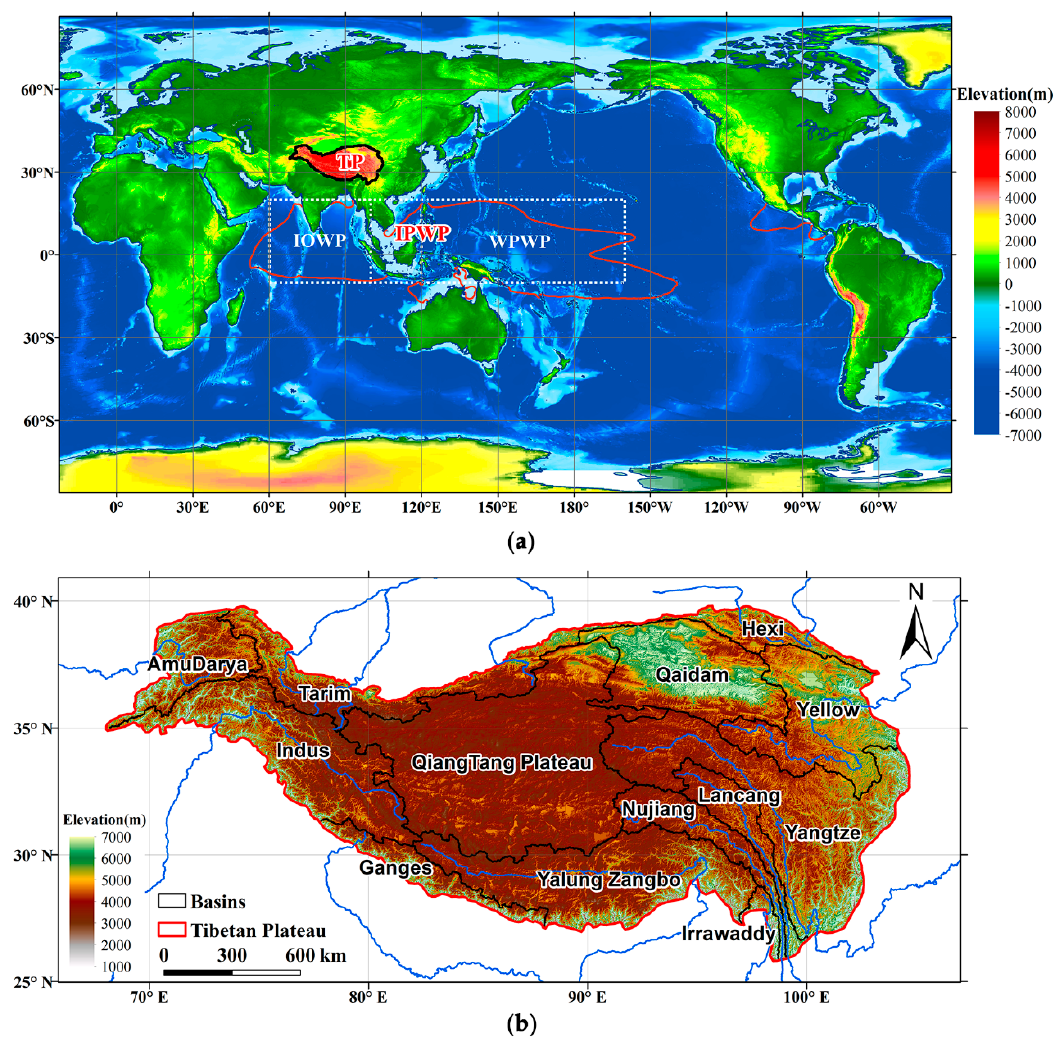
Figure 1. ( a ) The entire study area of the Tibetan Plateau (TP) where the black solid line (elevation greater than 2500 m) is the boundary of the TP, and the Indo-Pacific warm pool (IPWP), where the red line (SST greater than 28 ◦ C) is the annual-averaged boundary of the IPWP. The dotted white lines are the rectangular boundaries of the Indian Ocean warm pool (IOWP) and Western Pacific warm pool (WPWP). ( b ) The topography of the TP and its 13 basins.